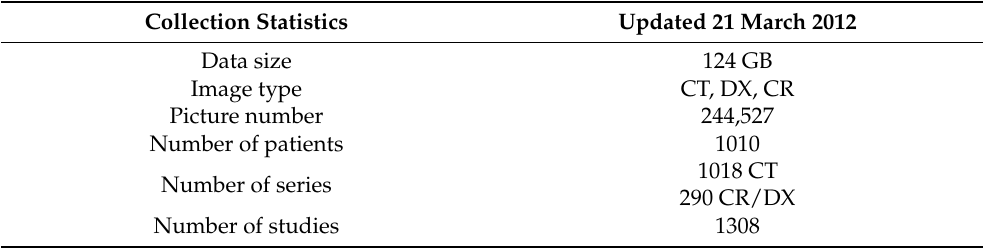
Table 1. Dataset